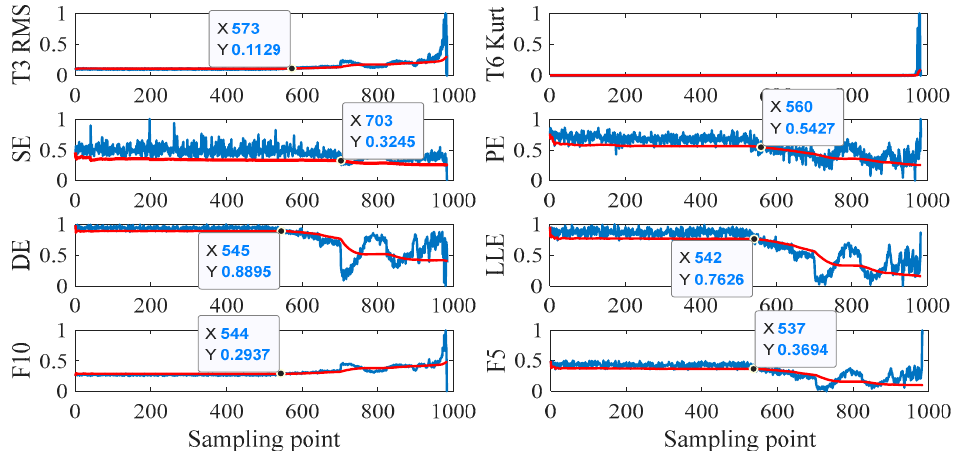
Figure 6. Bearing fault feature curve (blue curve) and state warning line (red curve).